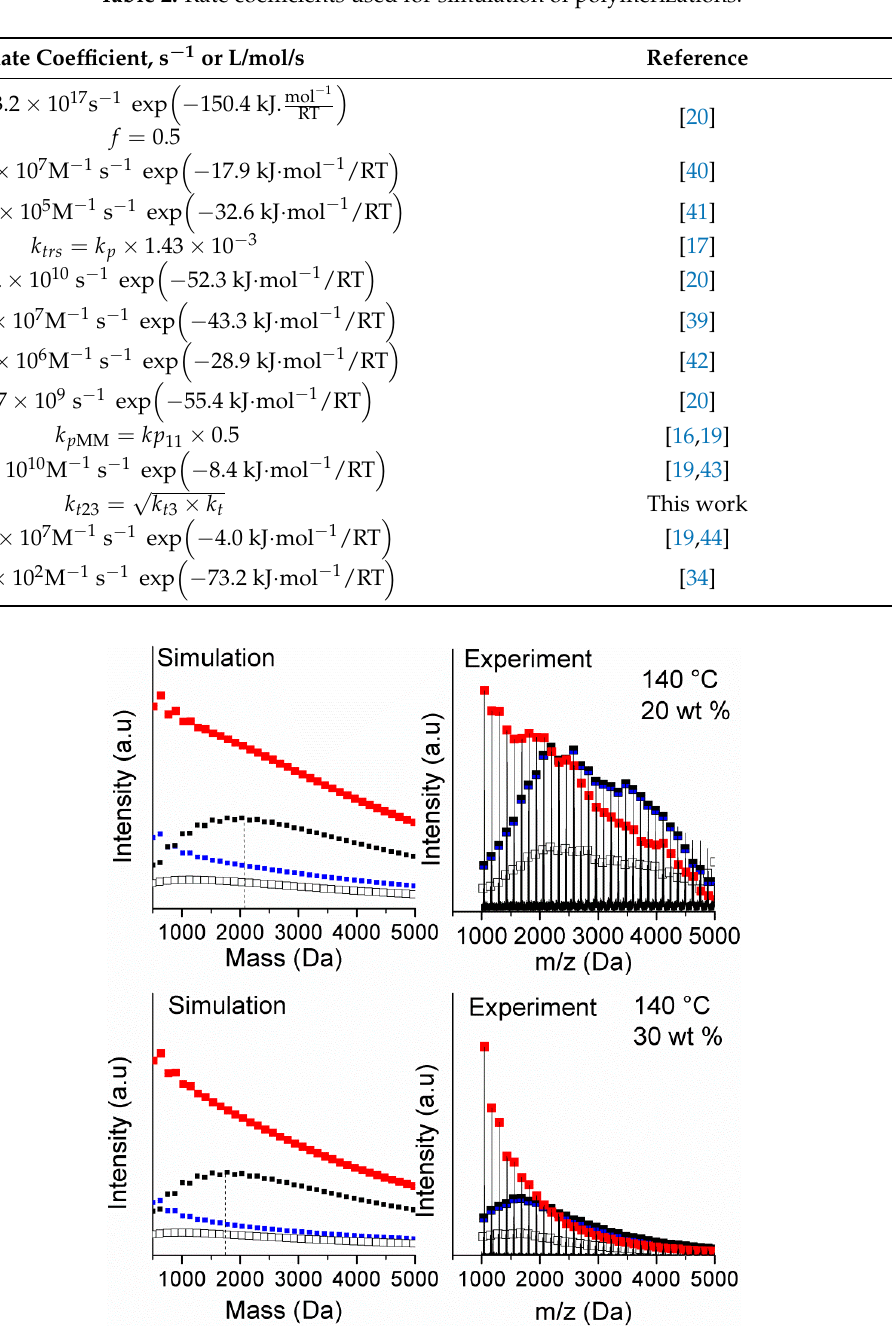
Table 2. Rate coefficients used for simulation of polymerizations.